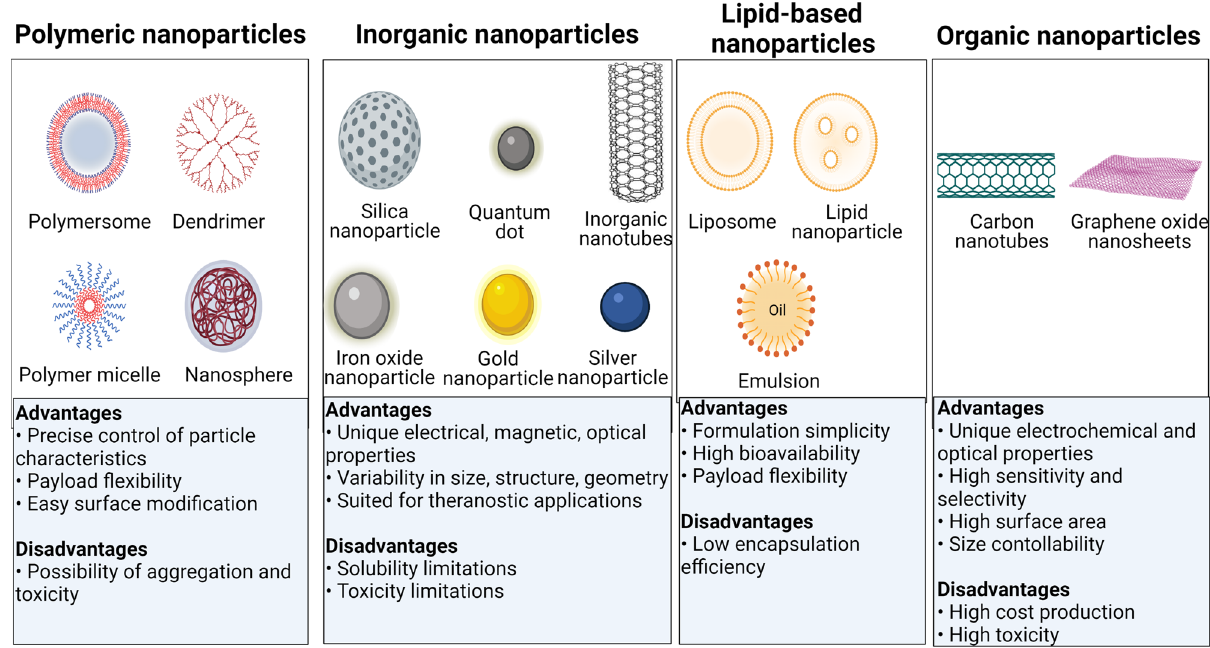
Figure 9: Advantages and disadvantages of major classes of nanoparticles used for combating COVID - 19